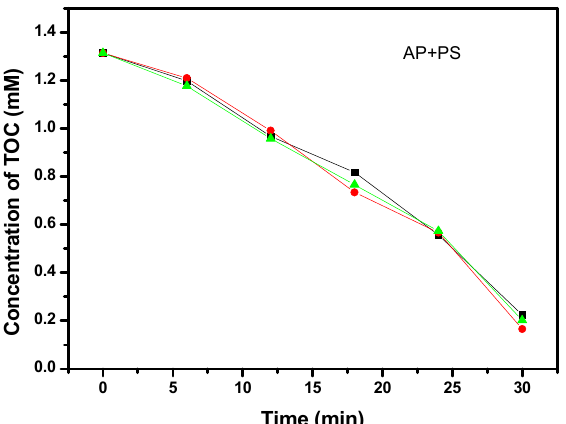
Figure 14. Concentration variation curves of total organic carbon during photocatalytic degradation of bisphenol A with Ag 3 PO 4 and potassium persulfate as catalysts under visible light irradiation for three cycles of degradation tests.